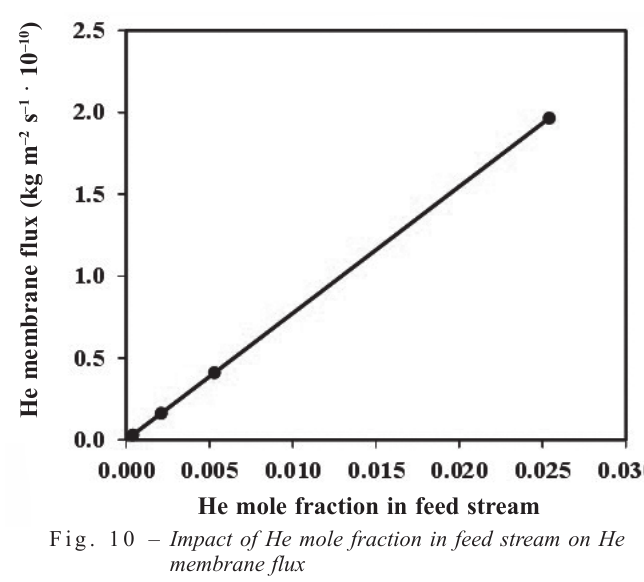
Fig. 9 – Impact of He mole fraction in feed stream on CH membrane flux